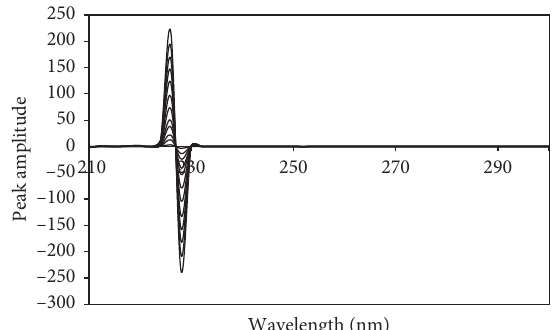
Figure 11: Successive derivative ratio spectra of 1, 3, 5, 8, 10, 15, 20,